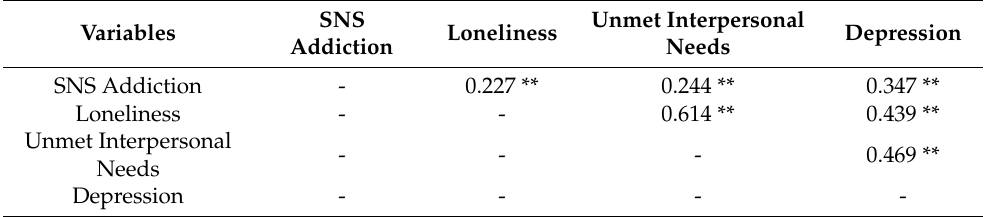
Table 3. Correlations between